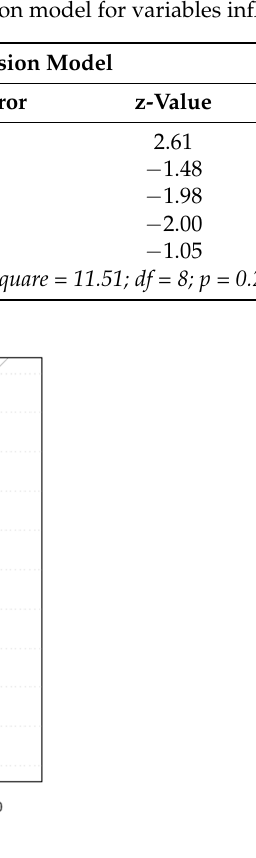
Figure A2. Validation of the logistic regression model by means of ROC curve and AUC value (AUC = 0.88).